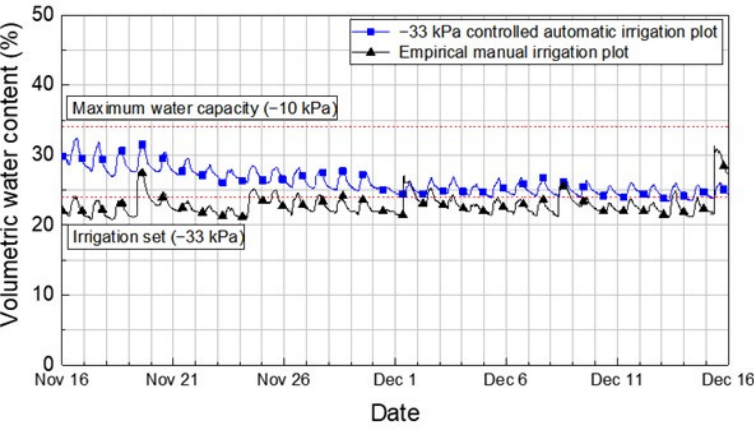
Figure 10. The results of soil moisture control in the − 33 kPa-controlled automatic irrigation plot during the second cropping season.